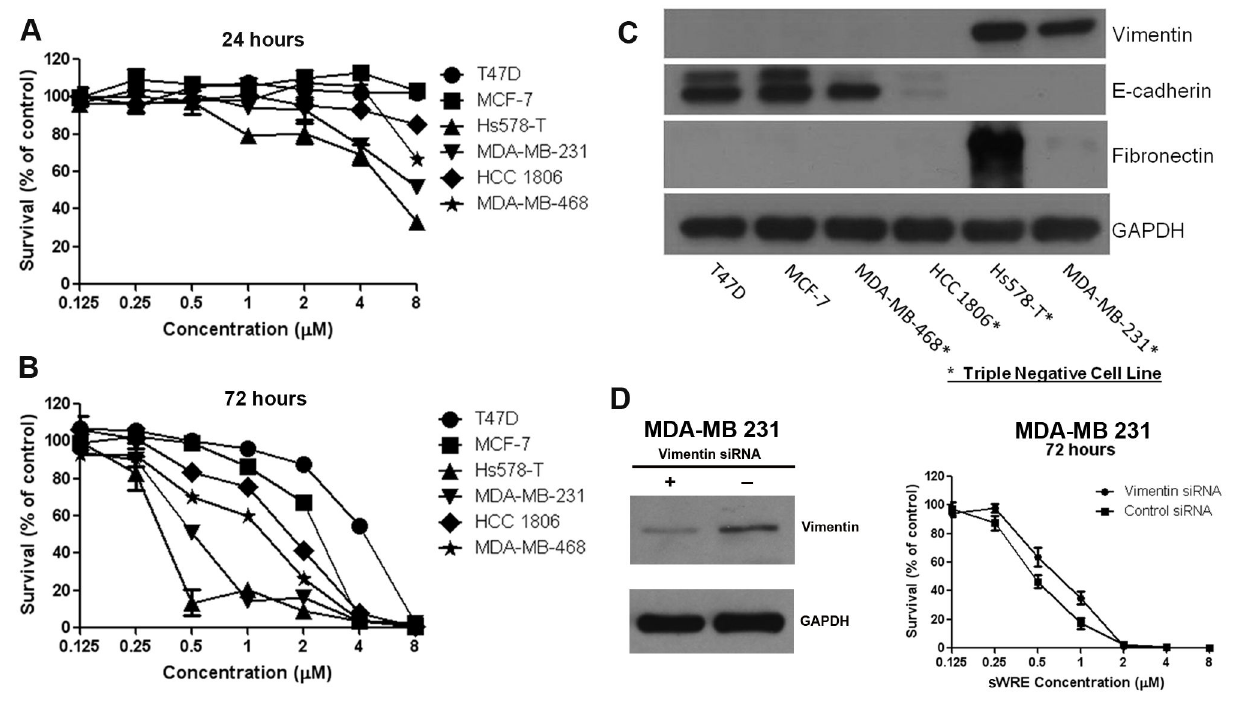
Figure 2. sWRE cytotoxicity in breast cancer cell lines. (A and B) Line graphs showing the % survival of six breast cancer cell lines treated with increasing concentrations of sWRE for 24 (A) and 72 (B) hours. (C) Western blot showing EMT markers in different breast cancer lines. Triple negative breast cancer cell lines are indicated with an asterisk. (D) (left) Western blot showing successful vimentin siRNA depletion (right) Cytotoxciity assay using sWRE in isogenic control and vimentin siRNA depleted cells. doi: